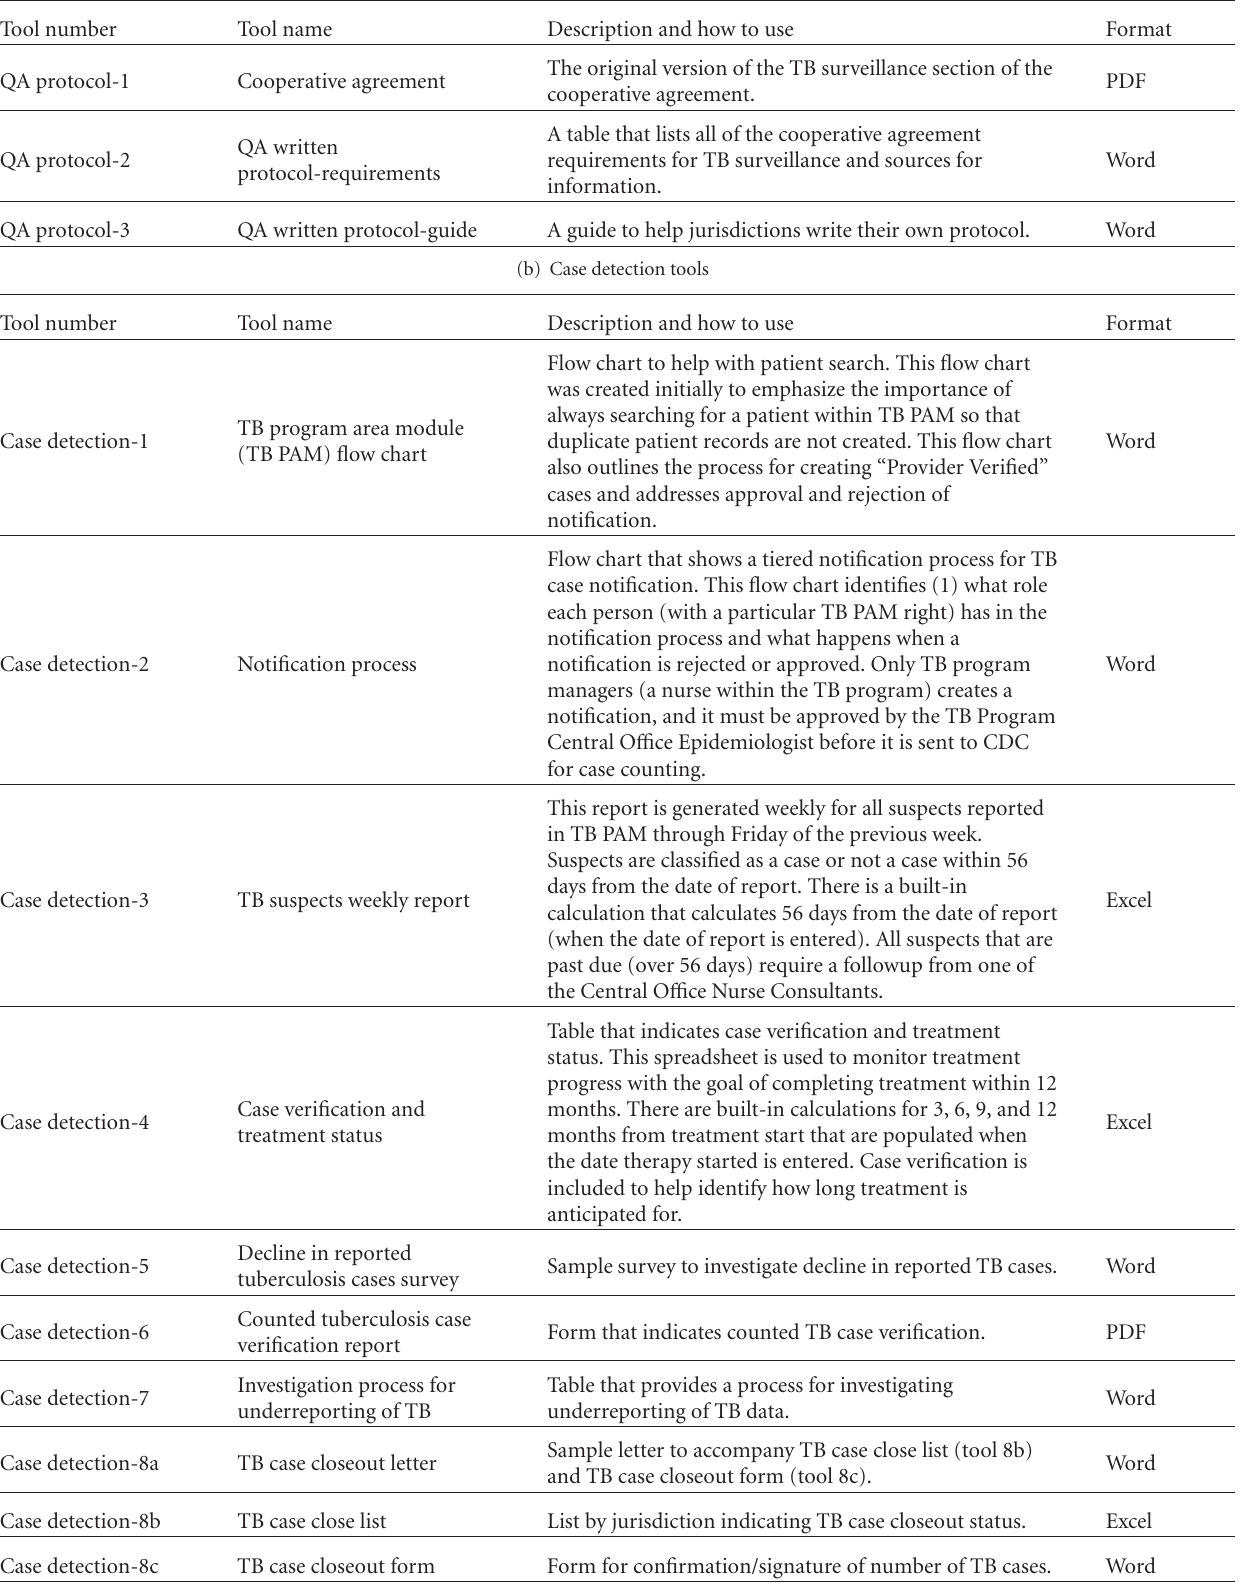
Table 2: Master list of quality assurance tools for TB surveillance, United States,